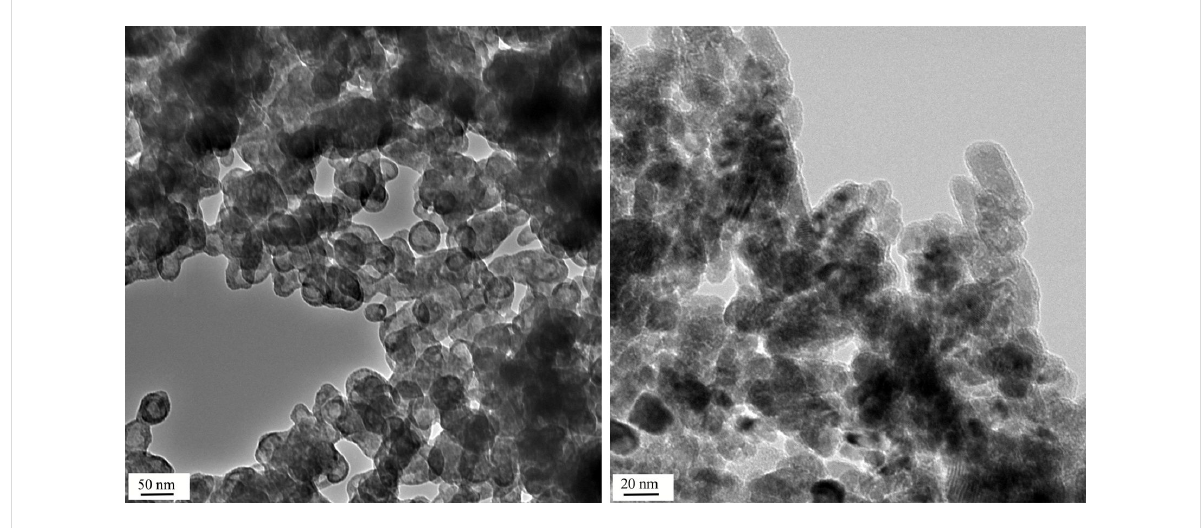
Figure 3: Left: TEM picture of degraded ZnO-NP 2 (labelled) after 1 hour of reaction with buffer B. The scale bar is 50nm. Right: Silica-coated ZnO- NP (sample 5 ). Shell thickness: 4–5 nm. The scale bar is 20 nm.